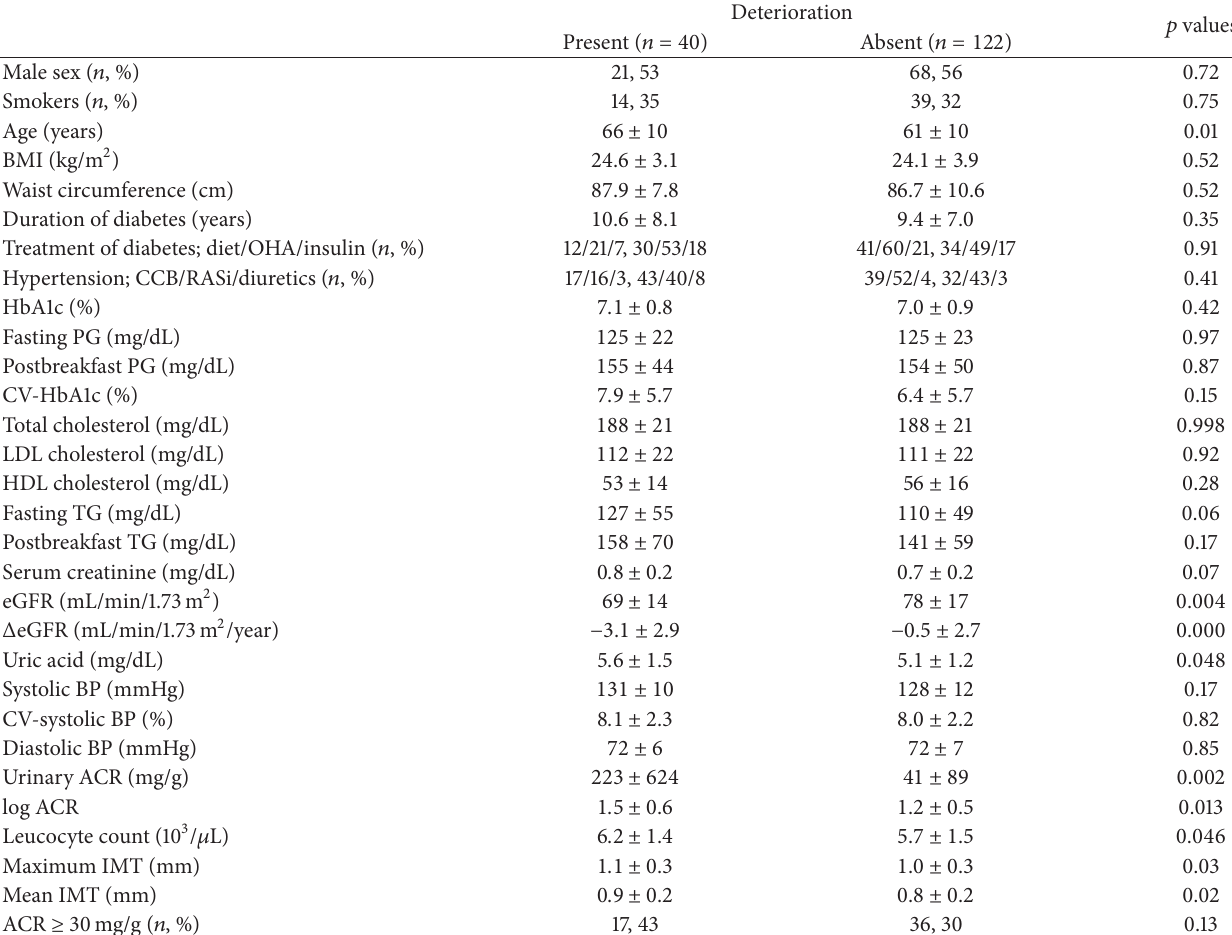
Table 2: Baseline clinical and biochemical characteristics of 162 type 2 diabetic patients whose kidney function deteriorated and did not deteriorate over a 6.0-year